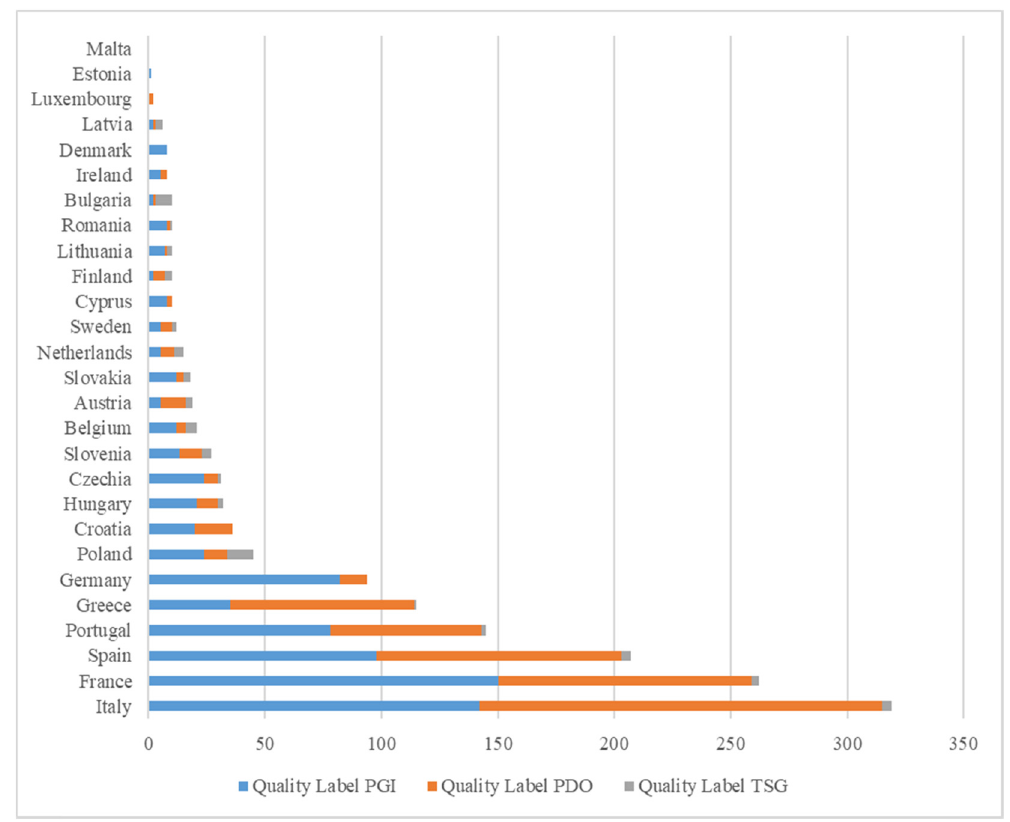
Figure 5: Traditional agri - food products in EU countries. Source: Own computation based on data gathered from eAmbrosia ( July 2022 )